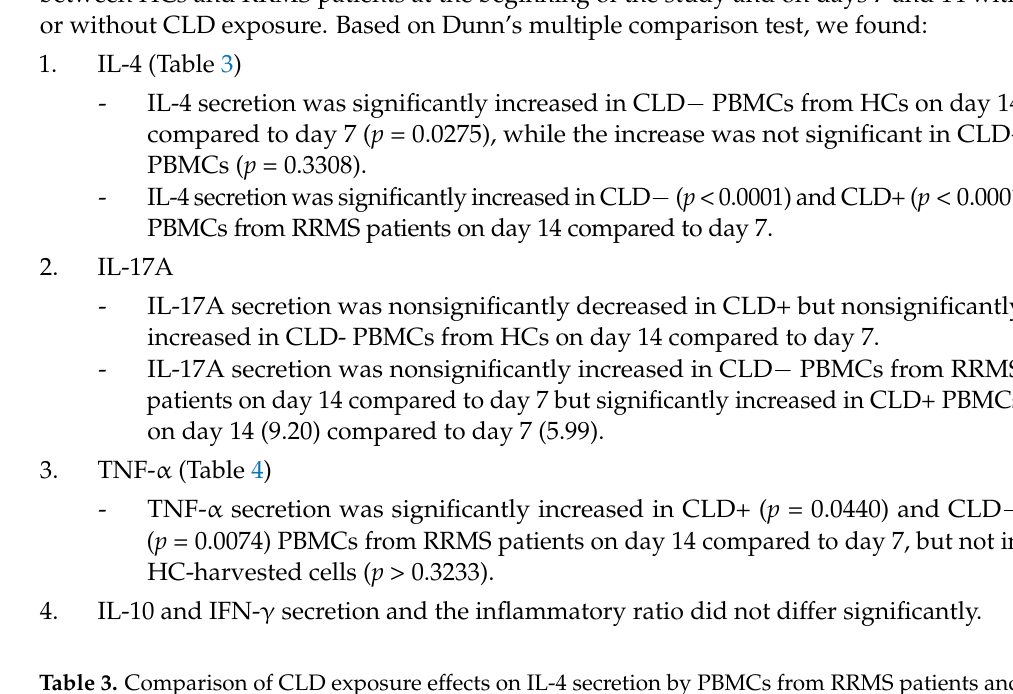
Table 3. Comparison of CLD exposure effects on IL-4 secretion by PBMCs from RRMS patients and HCs on days 7 and 14.